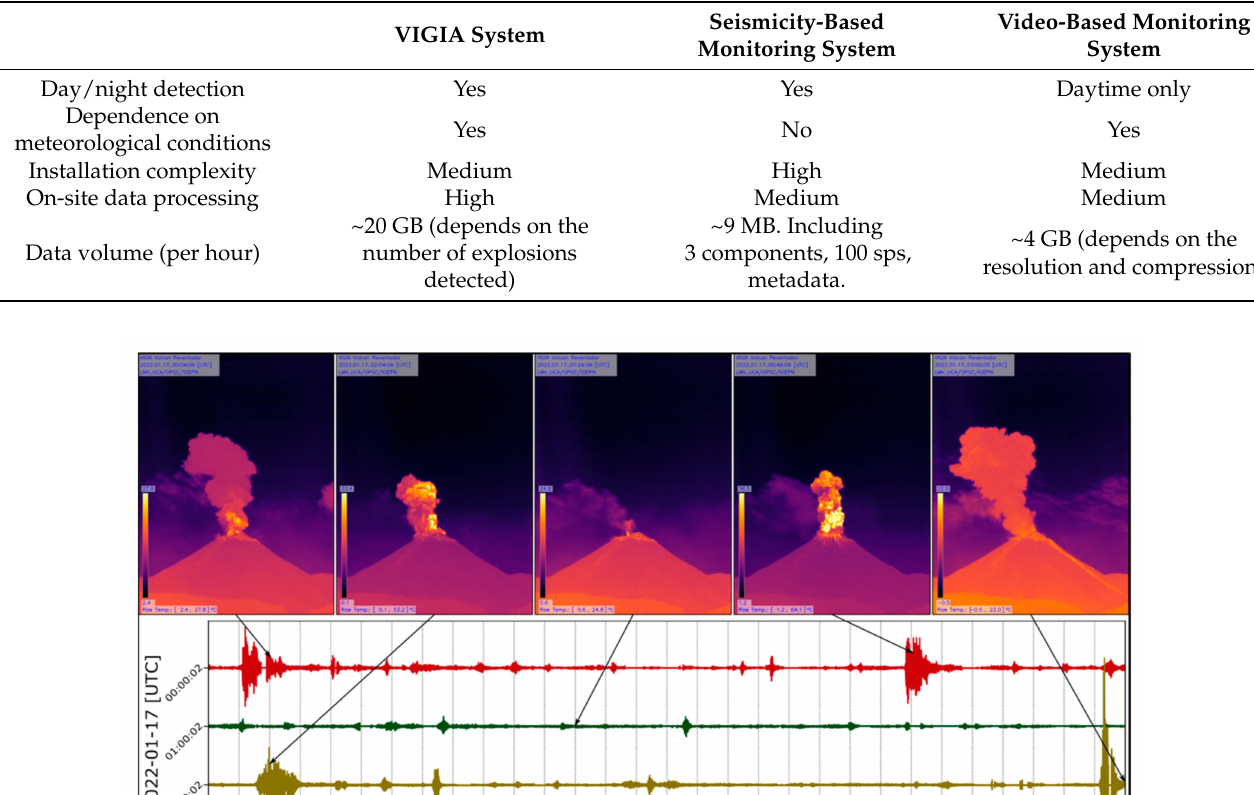
Table 1. Comparison between VIGIA and generic seismicity- and video-based monitoring systems.